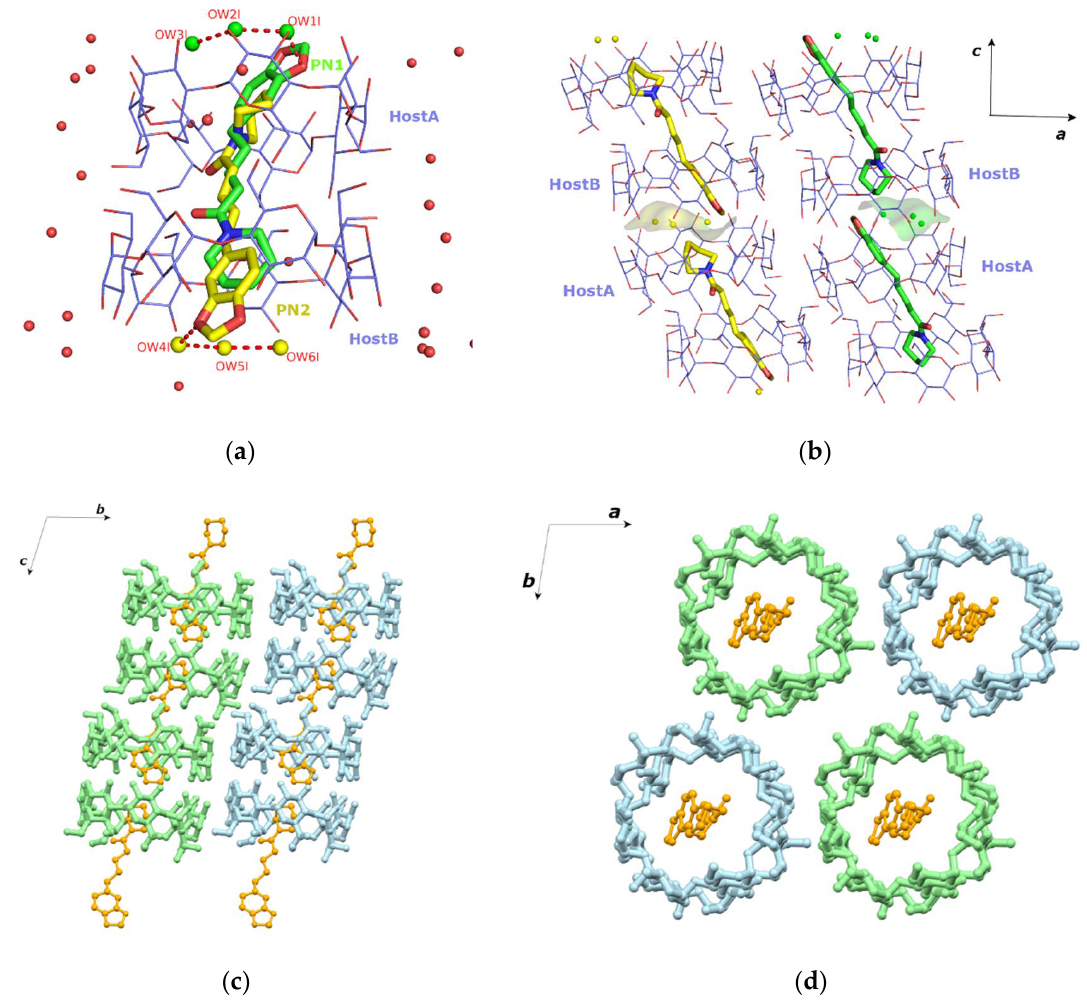
Figure 3. ( a ) The asymmetric unit of PN/ β- CD inclusion complex. A piperine (PN) molecule, disordered over two sites (PN1 green and PN2 yellow) of opposite orientation, is encapsulated in the cavities of two successive β- CDs (HostA and HostB) arranged in a tail-to-tail mode. ( b ) three water molecules, tethered via hydrogen bonds to an oxygen atom of the PN’s benzodioxole group, fill the void within the head-to-head β -CD dimers formed as usual via intermolecular hydrogen bonds between the secondary hydroxyls of β- CDs. ( c–d ) The crystal packing is characterized as channel mode ( CH ) along c axis. Only the PN2 site is depicted and hydrogens and waters are omitted for clarity. Images were generated by PyMoL and Mercury.